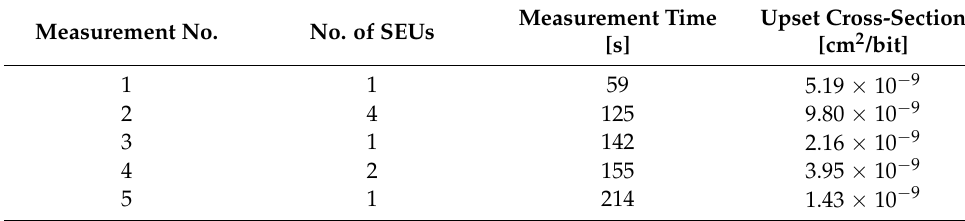
Table 5. SEU results under Kr irradiation. Measurement No.